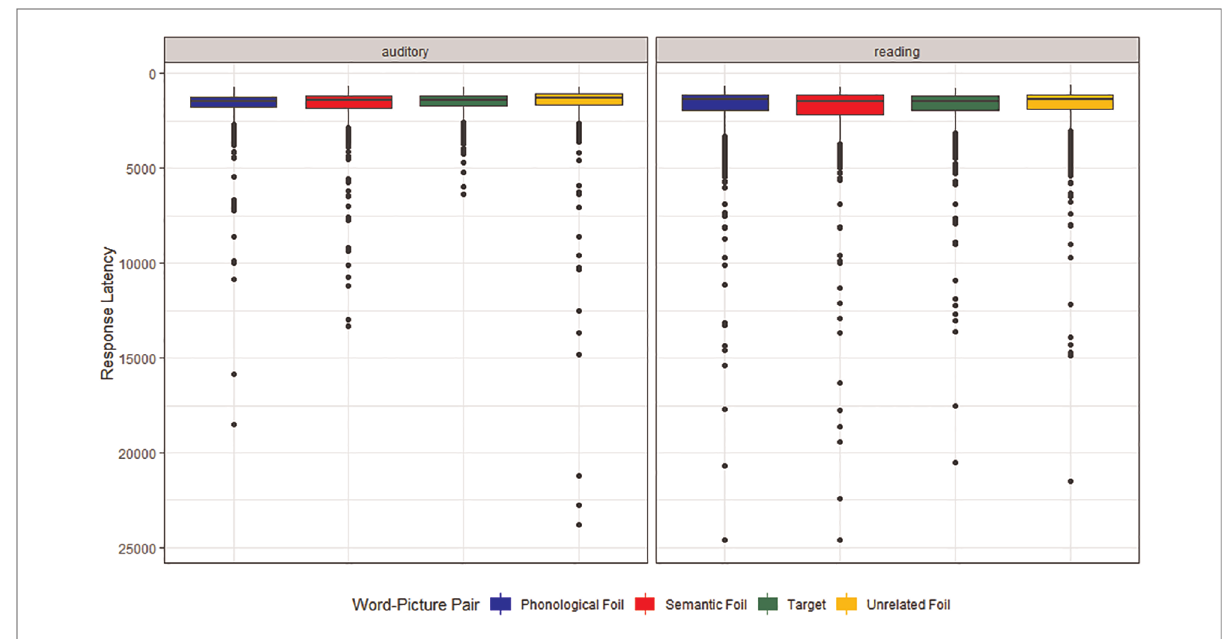
FIGURE 7 Response latency on auditory and reading veri fi cation tasks by word-picture